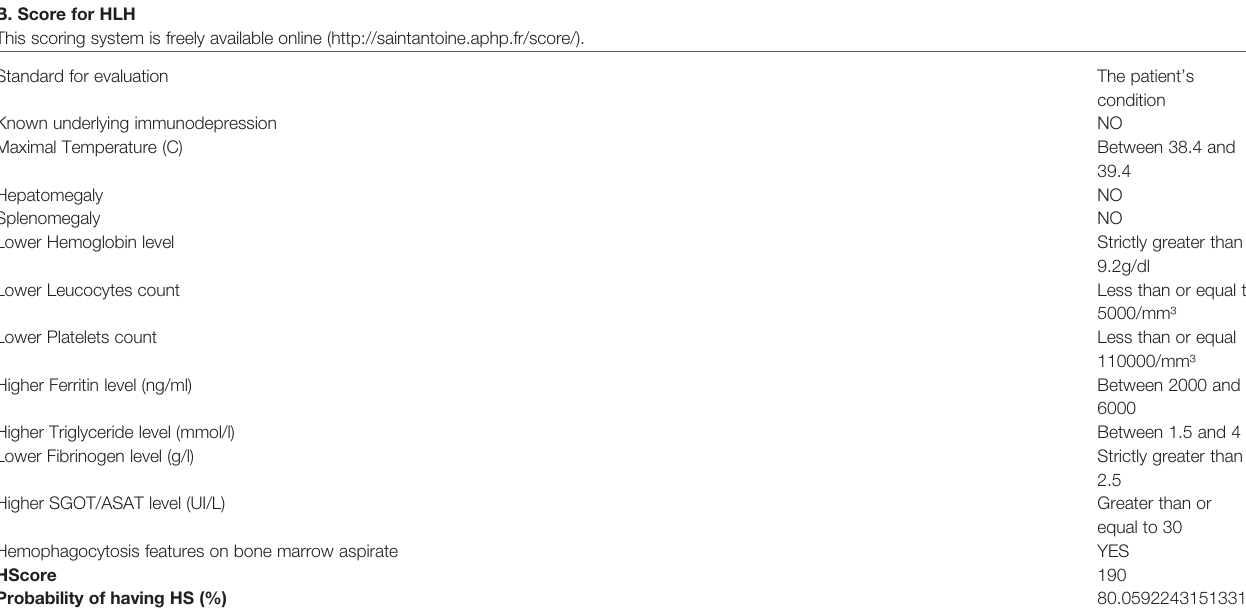
a tuberculosis infection T cell spot test, a cytomegalovirus PCR assay, and an EBV PCR assay were all negative. Finally, the patient was diagnosed as having HLH associated with Klebsiella pneumoniae .